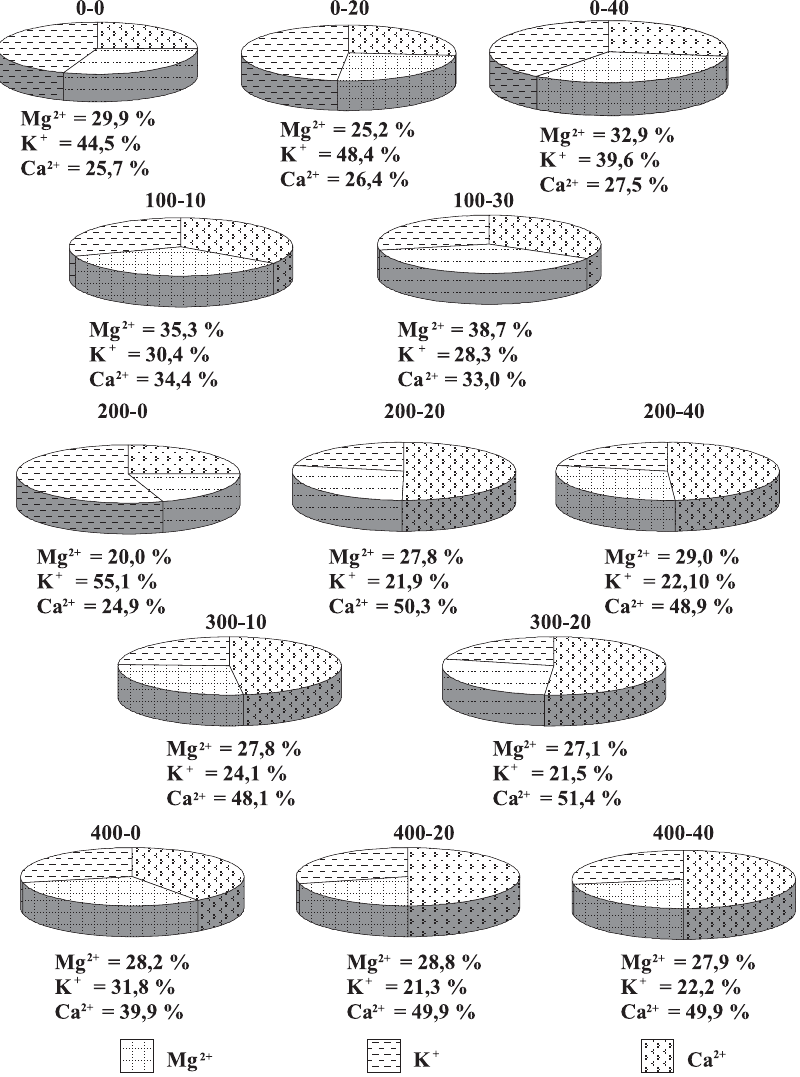
Figura 5. Proporções de K + , Ca 2+ e Mg 2+ no teor total (mmol aérea do capim-marandu, no segundo corte, em função das 13 combinações de doses de N e de